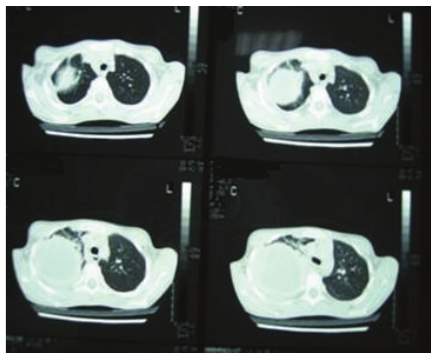
Figure 3: Computed tomography showed a large space-occupying solid and homogeneous right thoracic/mediastinal mass associated with pleural effusion.